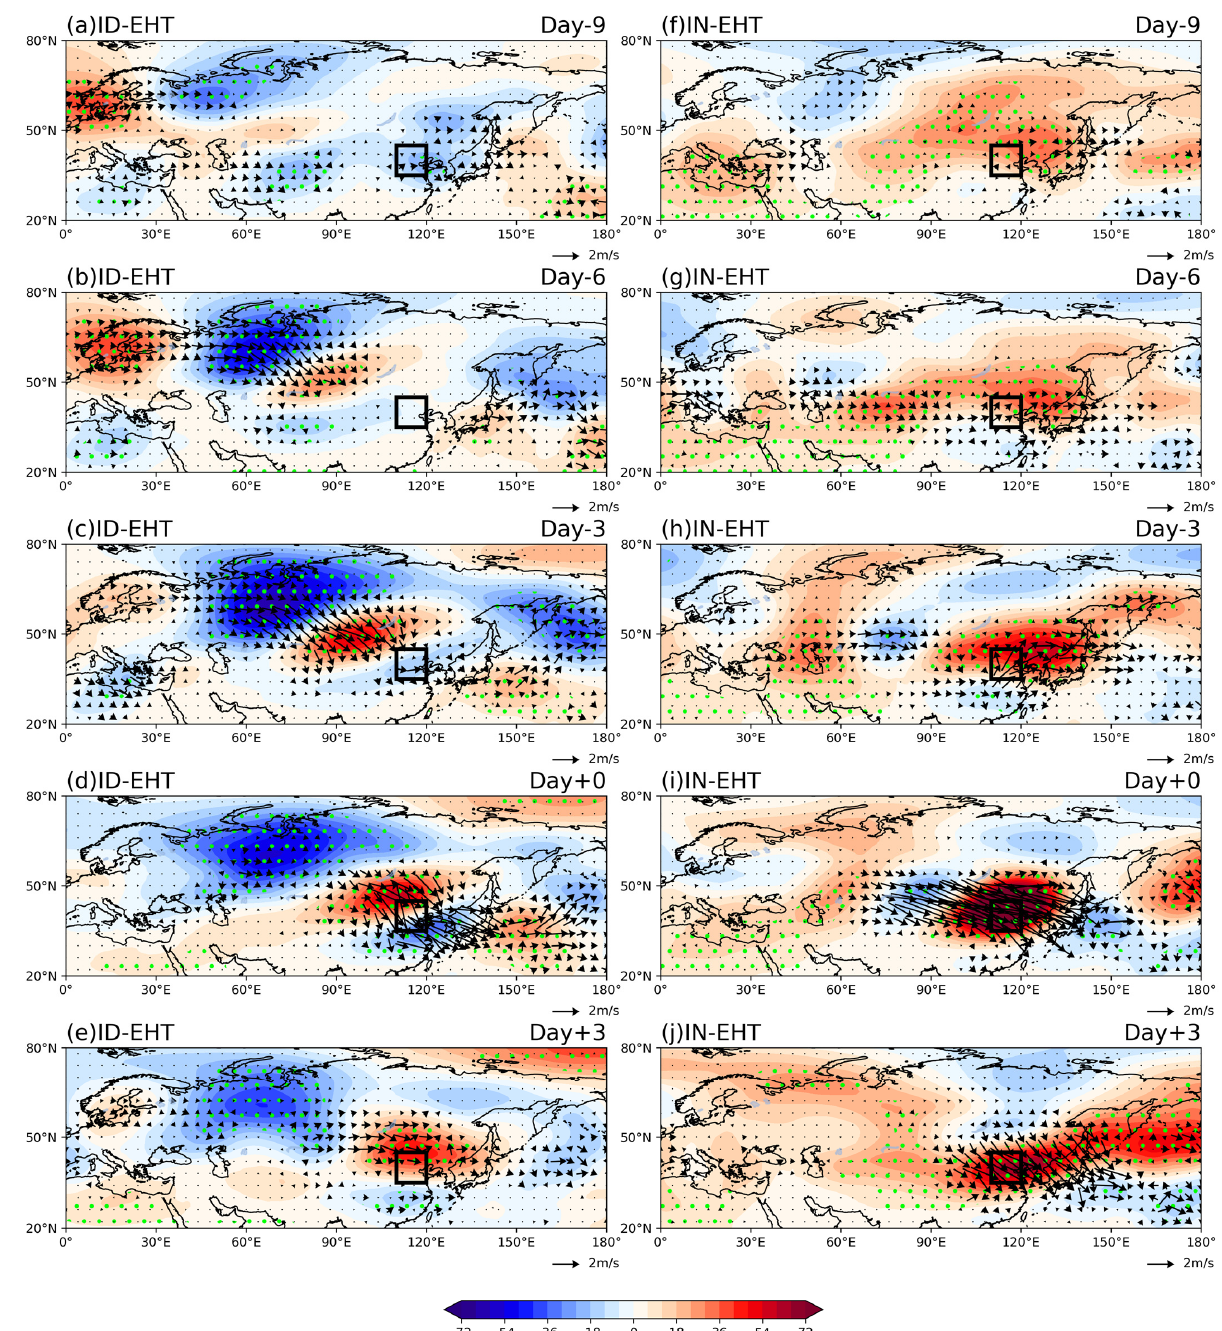
Figure 9. Composite evolution of 200 hPa geopotential height anomalies (shading; units: m) and the 200 hPa wave activity flux (arrows; units: m 2 /s 2 ) (from day − 9 to day +3 for ( a – e ): ID-EHT, ( f – j ): IN-EHT). Green dots indicate the anomalies significant at the 95% confidence level.